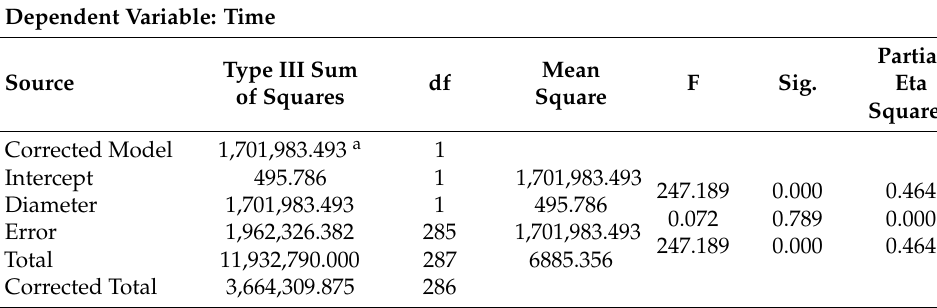
Table 12. Estimates and tests of effect